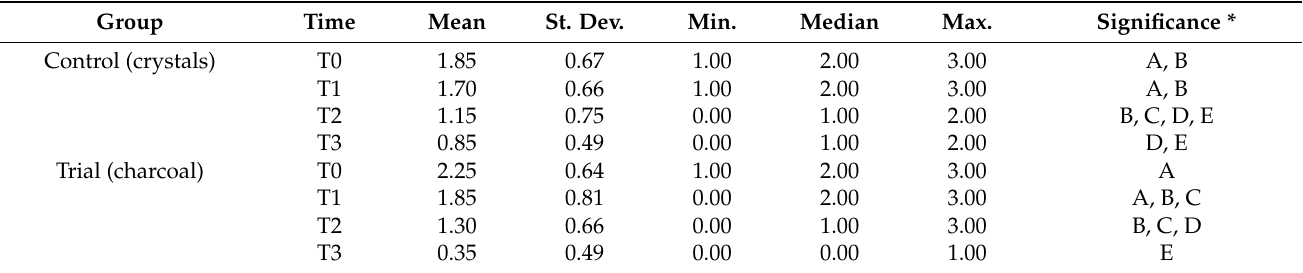
Table 6. Descriptive statistics of LSI-I, and significant intragroup and intergroup differences assessed by the Dunn’s post hoc test. * The means with the same letters are not significantly different ( p > 0.05).